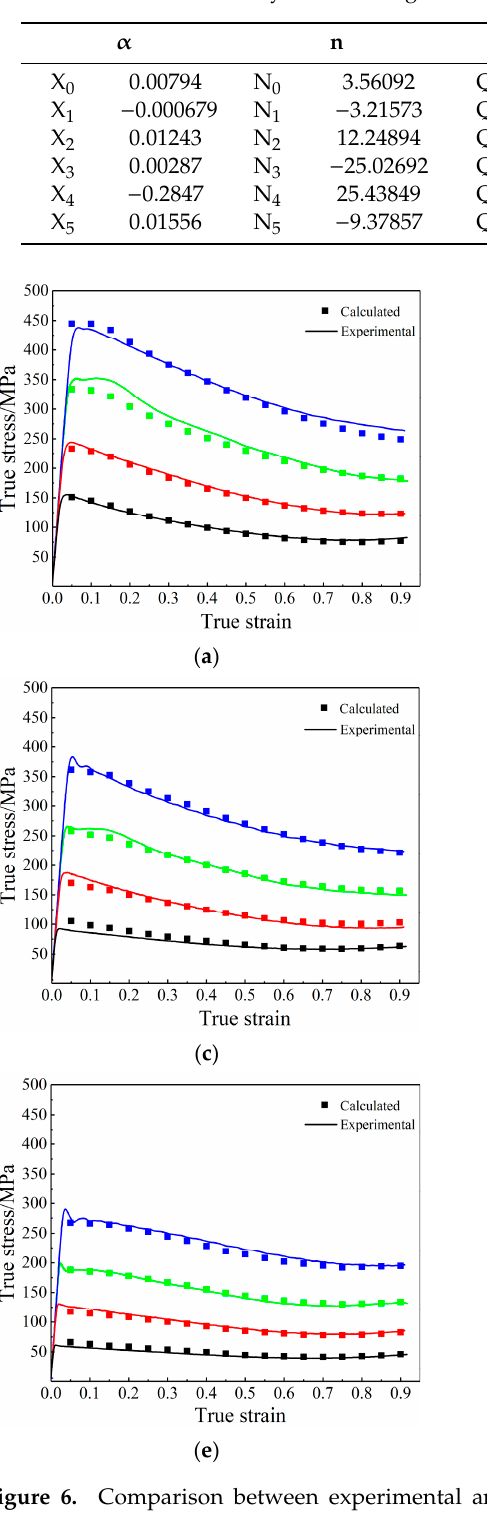
Table 5. Polynomial fitting results of a, lnA, n, Q in β phase region.